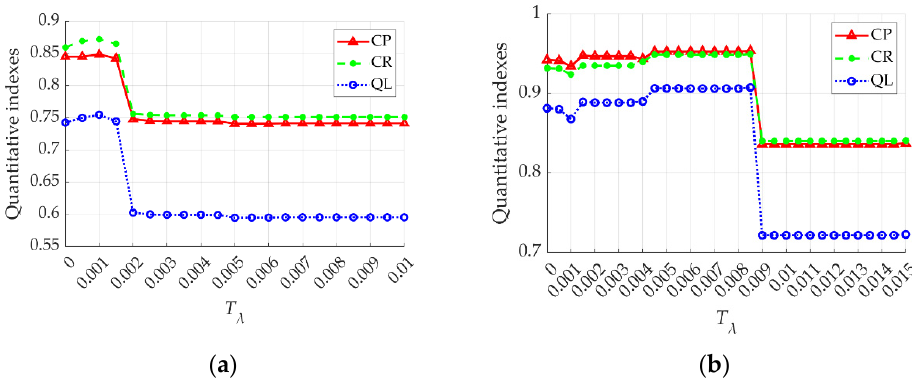
Figure 16. The quantitative indexes ( CP , CR , QL ) versus the threshold T λ in the experiments. ( a ) Re- sults for test image 2. ( b ) Results for test image 6.